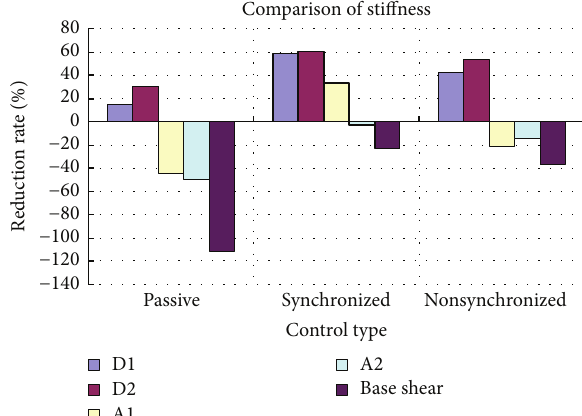
Figure 17: Comparison of shock absorption ratios of the test struc- ture with synchronous and asynchronous control under excitation of the Kobe